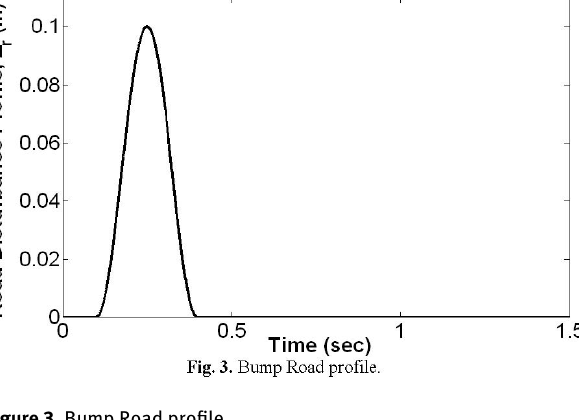
Figure 3. Bump Road